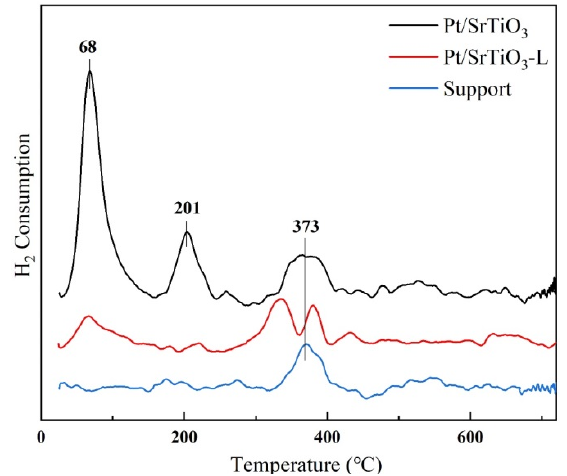
Figure 3. H 2 -TPR profiles of samples.